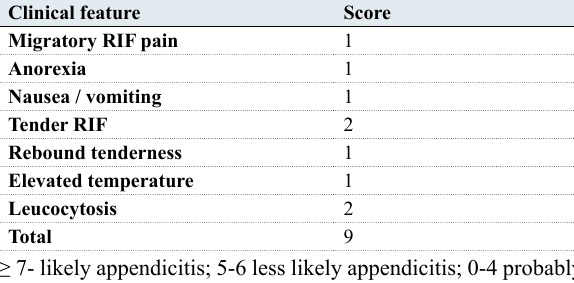
Table 1: Modified Alvarado Scoring system Clinical feature